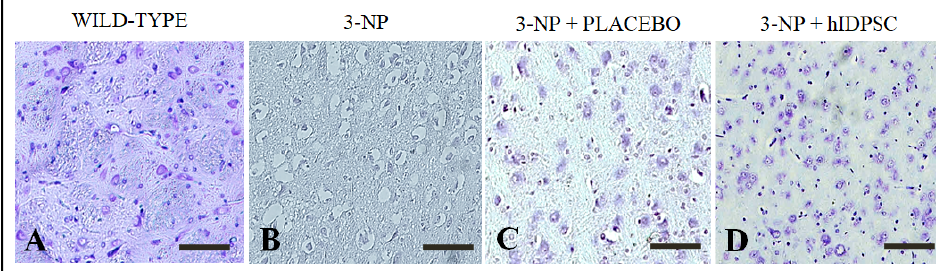
Figure 3. Nissl staining showing: ( A ) Neuronal integrity within the striatum of rats not treated with 3-NP (wild-type), Necrotic neurons within the striatum of rats treated with 3-NP ( B ) and saline (placebo). ( C ). Reduced number of necrotic neurons within the striatum of 3-NP rats treated with hIDPSCs. ( D ). Imagens captures using objectives of 20× ( A – C ) and 10×. ( D ). Scale bar of 50 μ m ( A – C ) and 100 μ m. ( D ). Images observed in rats euthanized at day 95 (D95).